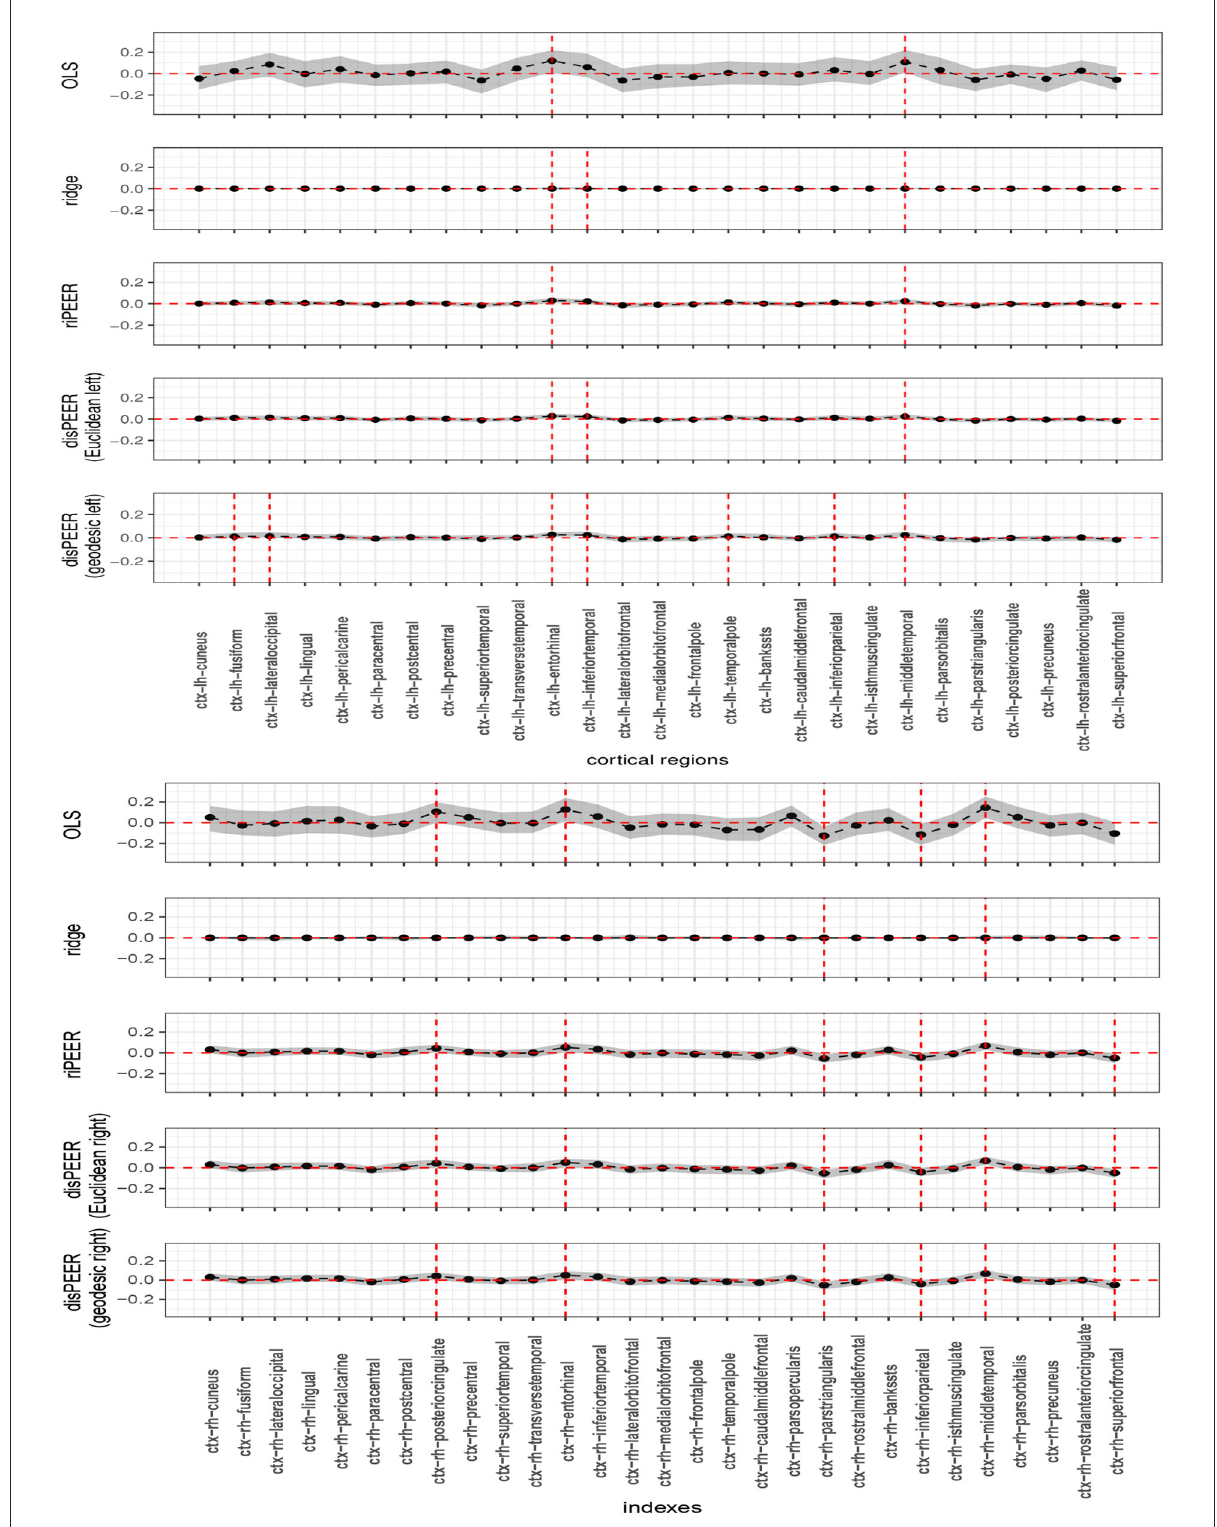
FIGURE8 Estimates of b for Language/Vocabulary Comprehension cognitive function with non-adjusted 95% bootstrap-based confidence intervals denoted for left and right hemisphere ( top and bottom , respectively). Results are presented as estimates (solid black lines), coefficient confidence intervals (shaded areas), zero line (horizontal red line), and significant coefficient at 95% level (vertical red